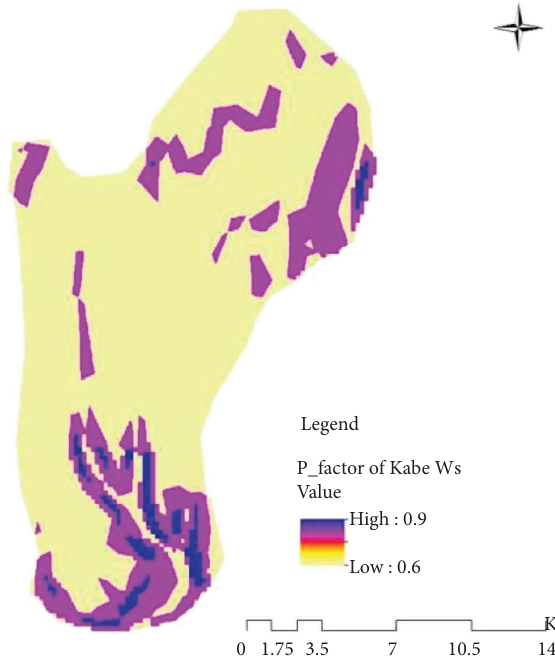
Figure 7: Te conservation practice ( P -factor) map.